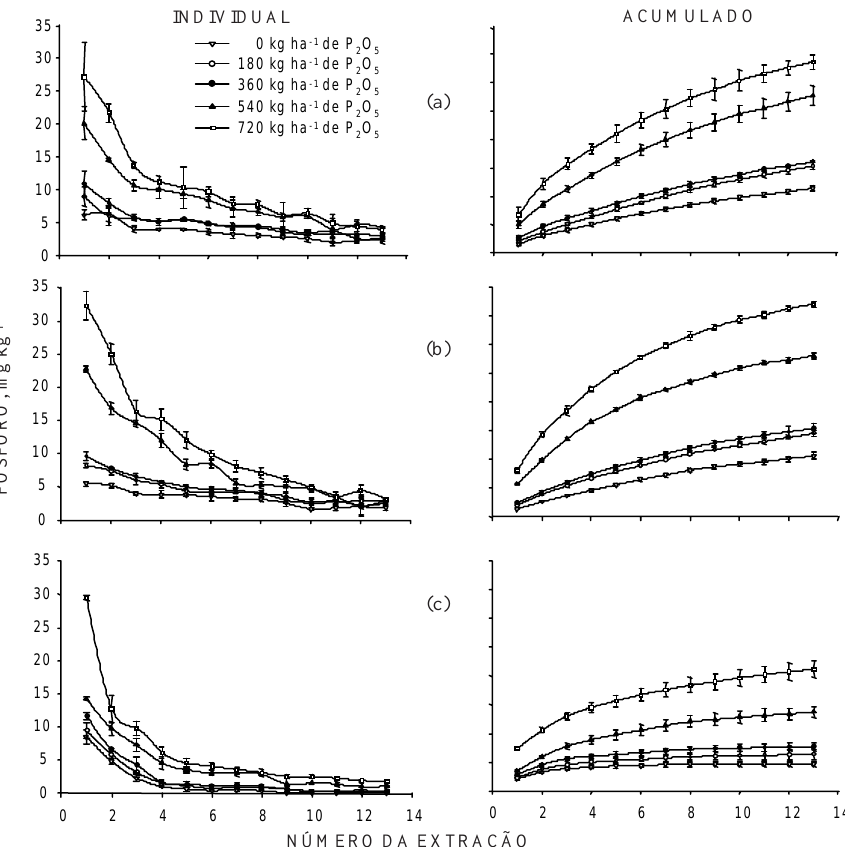
Figura 1. Dessorção de fósforo de um Latossolo Vermelho distroférrico típico com doses de fósforo adicionado, submetido a extrações sucessivas com Mehlich-1 (a), Mehlich-3 (b) e RTA